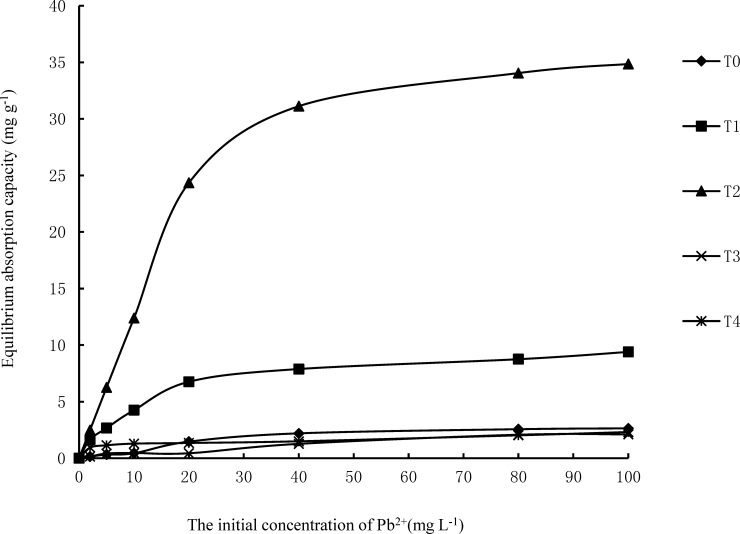
The adsorption isotherms and adsorption rate curves of Pb2+ by the original alum plasma and ameliorated alum plasma (pH = 6, 25°C).